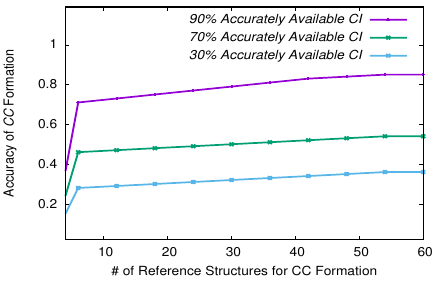
Figure 9. Accuracy of CC Corresponding to the number of Reference Structures of Context Information